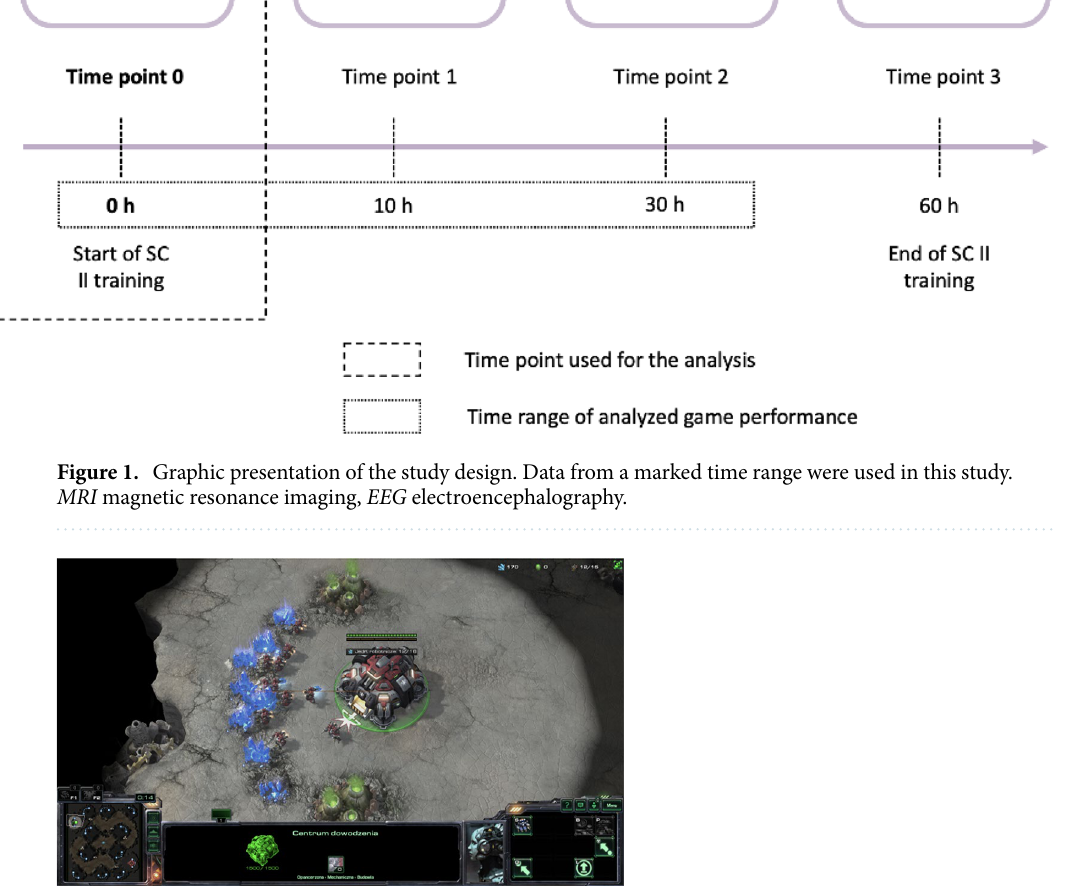
Figure 2. Screenshot of the StarCraft II (©2022 Blizzard Entertainment, Inc.) match played by one of the